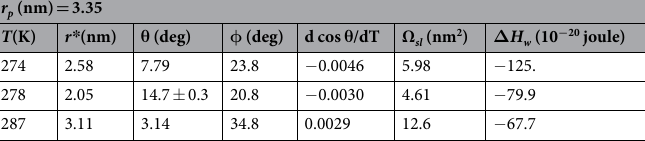
Table 3. Continuation of Table 1 to include additional parameters derived using the Fletcher spherical cap model of classical nucleation theory. The critical radius, r * , results from measured S onset and the Kelvin relation using surface tensions and density of water from ref. 15 . θ is the directly determined microscopic contact angle is the contact [7] and d cos Θ /dT its temperature dependence. Angle ψ , not tabulated, equals θ + φ (Fig. 3). Ω sl is the microscopic heat of wetting from Equation (23). Uncertainty area between the cap and the seed and Δ H w limits at = T K 278 are from ref. 7